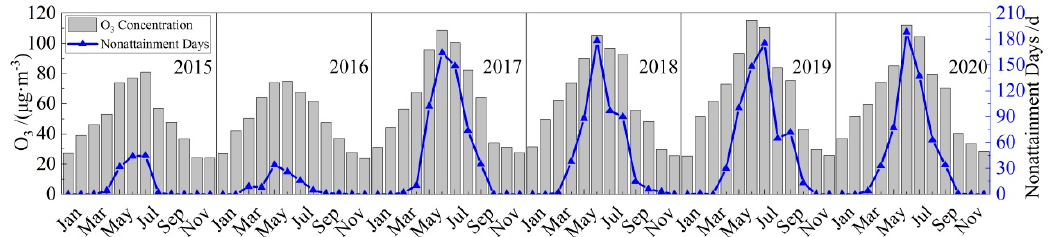
Figure 4. Variations of monthly mean O 3 mass concentration and cumulative nonattainment days of Shanxi Province during 2015 −